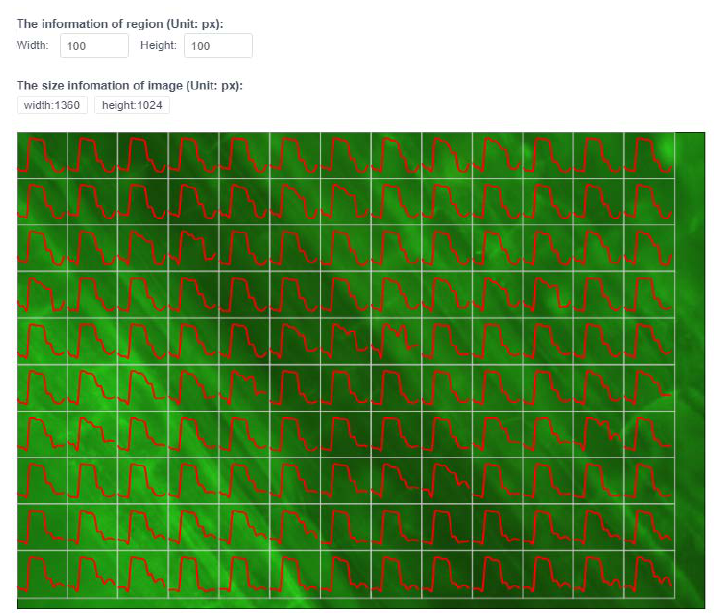
Figure 9. Web-based spatiotemporal visualization of plant electrical signals. Appl. Sci. 2018 , 8 , x FOR PEER REVIEW